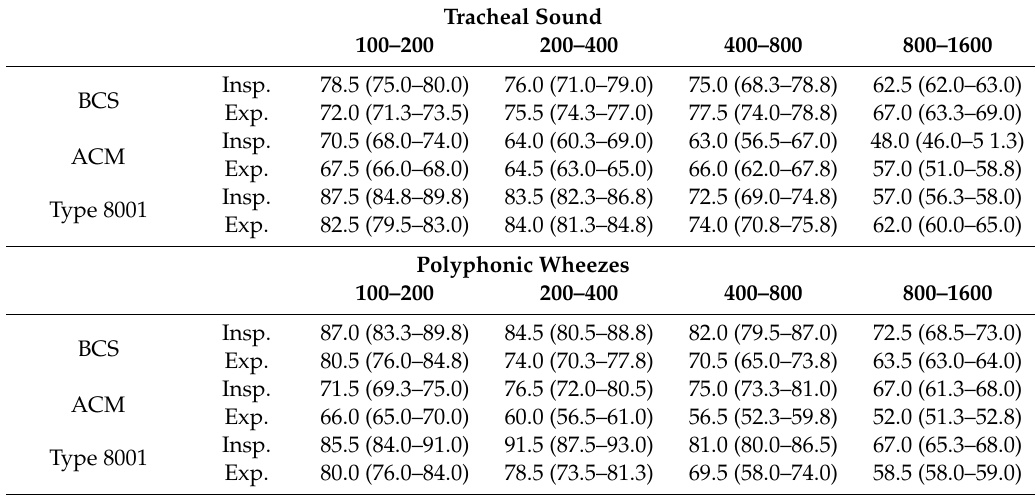
Table 4. Power median (0.25–0.75%) value (dB) in each frequency